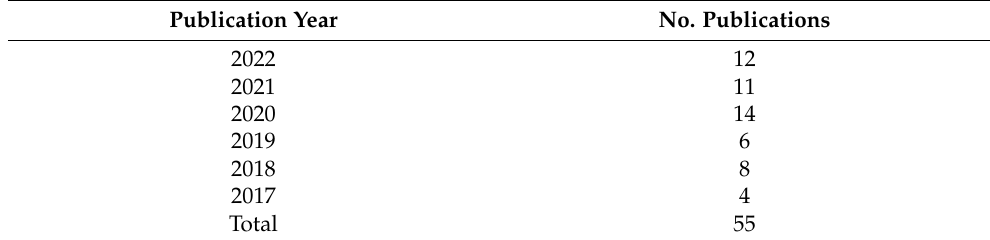
Table 1. Number of publications on “Solo Travel” by year.